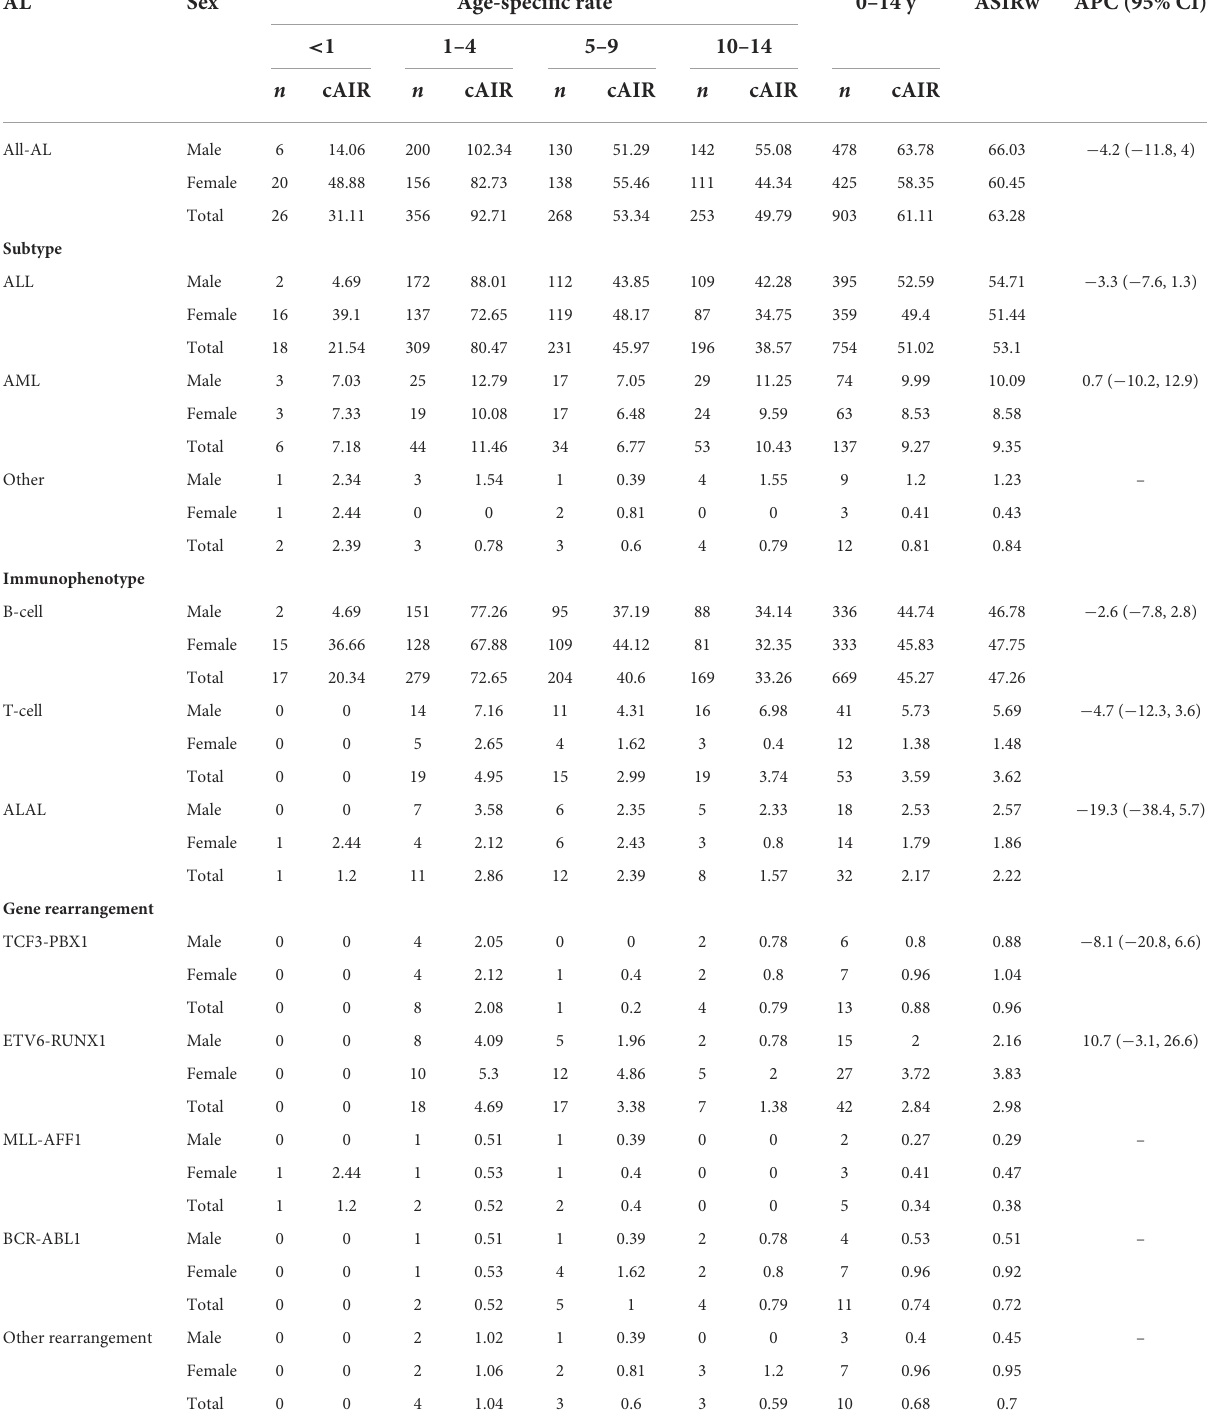
TABLE 1 The incidence rate of AL among children in MC, based on the MIGCCL registry during the period